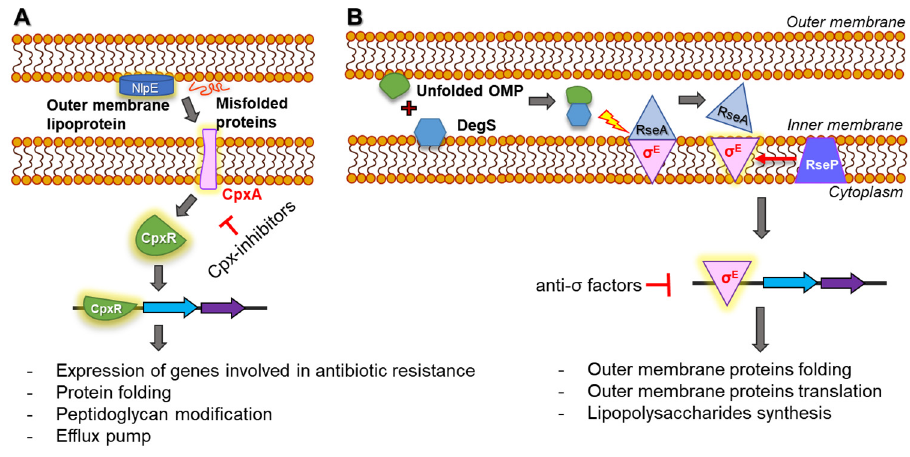
Figure 9. Cpx- ( A ) and σ E -regulated ( B ) envelope stress responses in bacteria